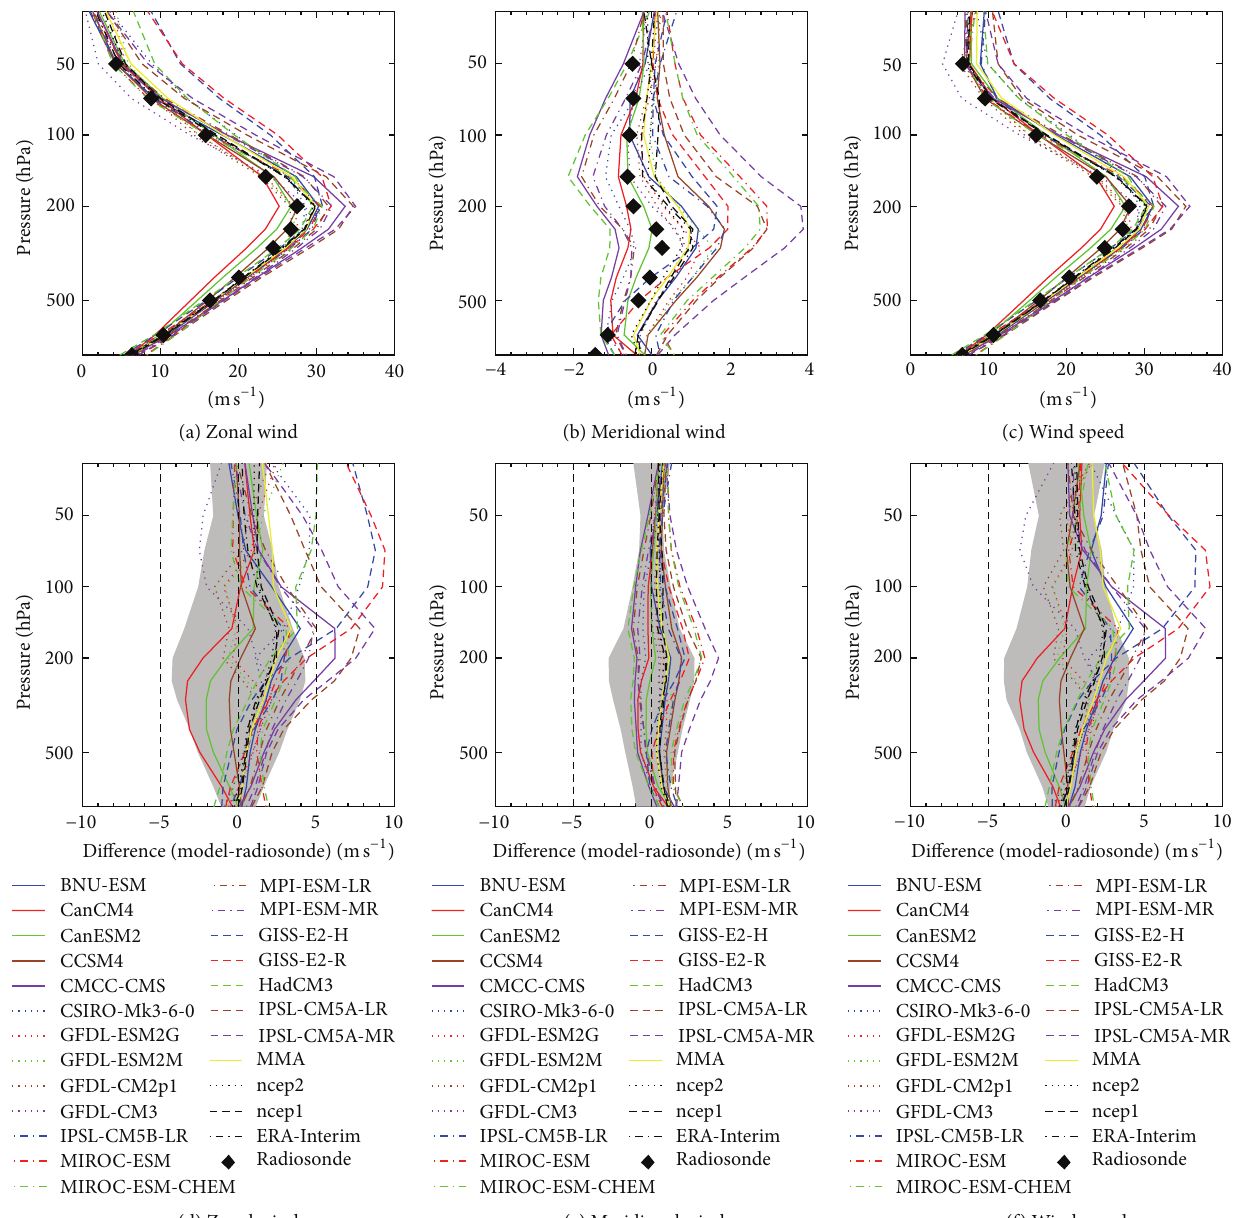
Figure 4: Annual mean climatology (a, b, and c) and climatology difference (bias) relative to radiosonde observation (d, e, and f). The period of study is 1979–2005 from 850 hPa to 30hPa pressure levels. The radiosonde plus and minus 2 standard deviations around the climatology mean is displayed as the gray shading in the bias plot (d, e, and